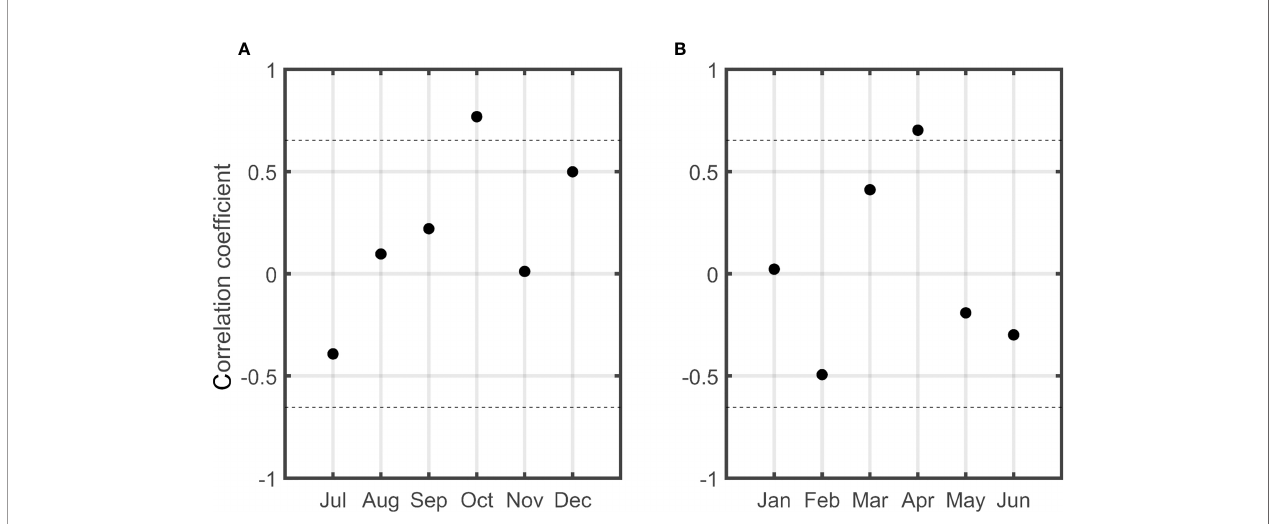
Table 1 . The intrusion of the upper-layer Kuroshio frequently occurs off the northeastern coast of Taiwan, which is indeed a normal fl ow pattern that occurs when a strati fi ed geostrophic current encounters a topographic rise. Considering the temporal evolution of impinging eddies east of Taiwan, satellite geostrophic currents in and around the cold dome, shoreward Ekman transport calculated by Eq. (1), and sea surface cooling due to winter atmospheric cold surges in association with spawning periods, the potential dynamics of the intrusions are attributed to three categories: 1) the joint in fl uence of impinging eddies and shoreward Ekman transport for events 1, 4, and 8; 2) shoreward Ekman transport for events 2, 5, 6, 9, and 10; and 3) strong cold surge-induced shelf water cooling for events 3 and 7 ( Table 1 ). The shortest period of intrusion was 42 days, and the longest was 84 days over 2008 – 2017. The typical fl ow fi eld and temperature anomaly in the cold dome of the three dynamic regimes are discussed later.